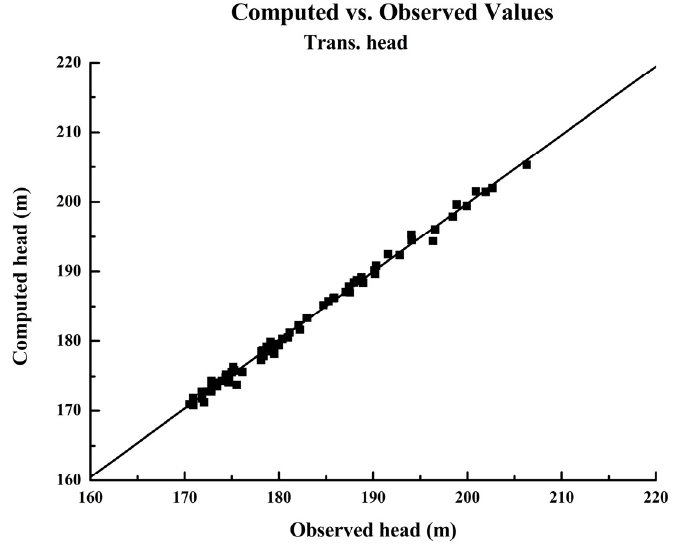
Figure 12. Scatter plot of observed versus computed values of head for model